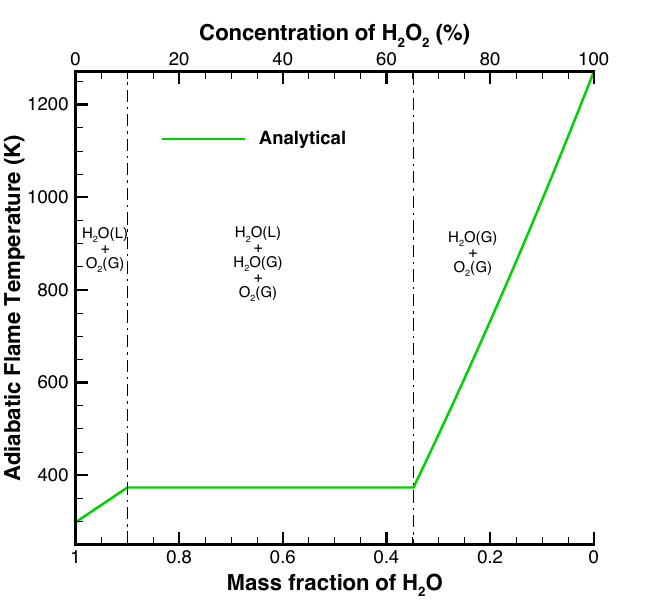
Figure 2. Plot of the adiabatic flame temperature of hydrogen peroxide as the concentration is